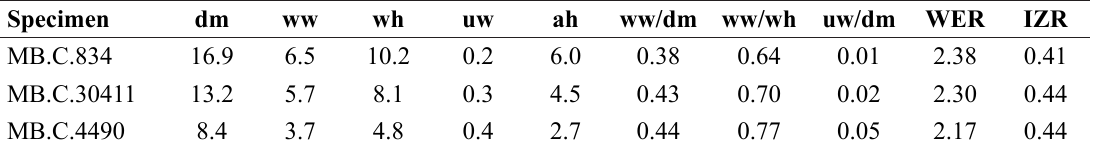
Table 2. Conch dimensions and ratios of Tornoceras frechi Wedekind, 1918 from the Red Ironstone of